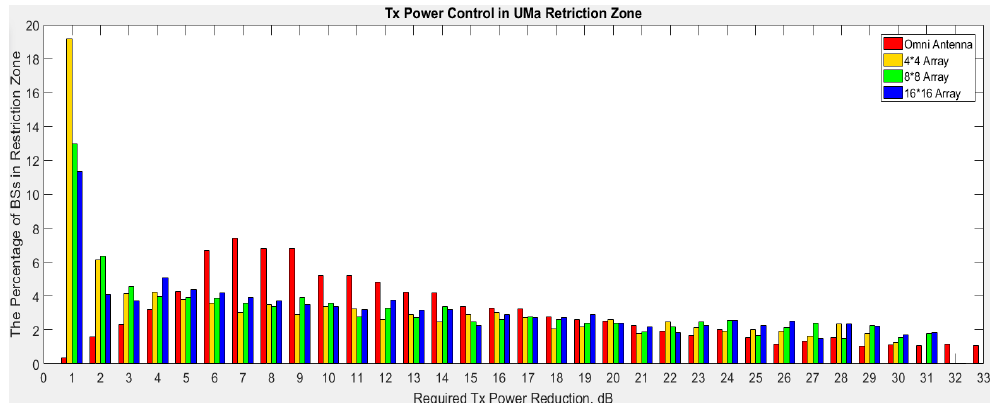
Figure 29. Tx power control chart in UMa restriction zone. Table 5. Mean Tx power reduction in the restriction zone and the BS Tx power control in Uma.